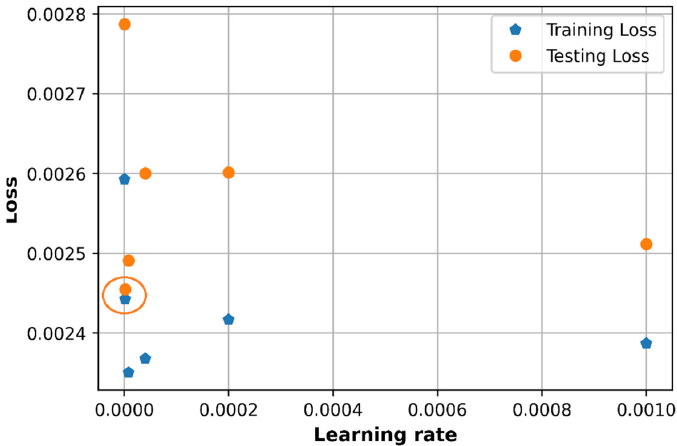
Figure 13. Comparison of loss with different learning rate.